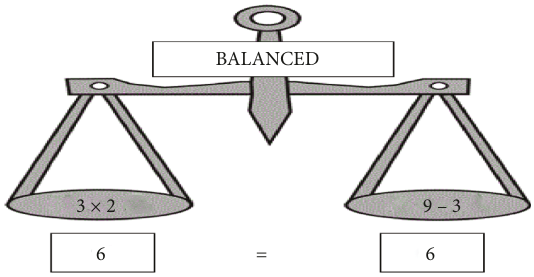
Figure 2: Students’ design of the arithmetic balance in equations.